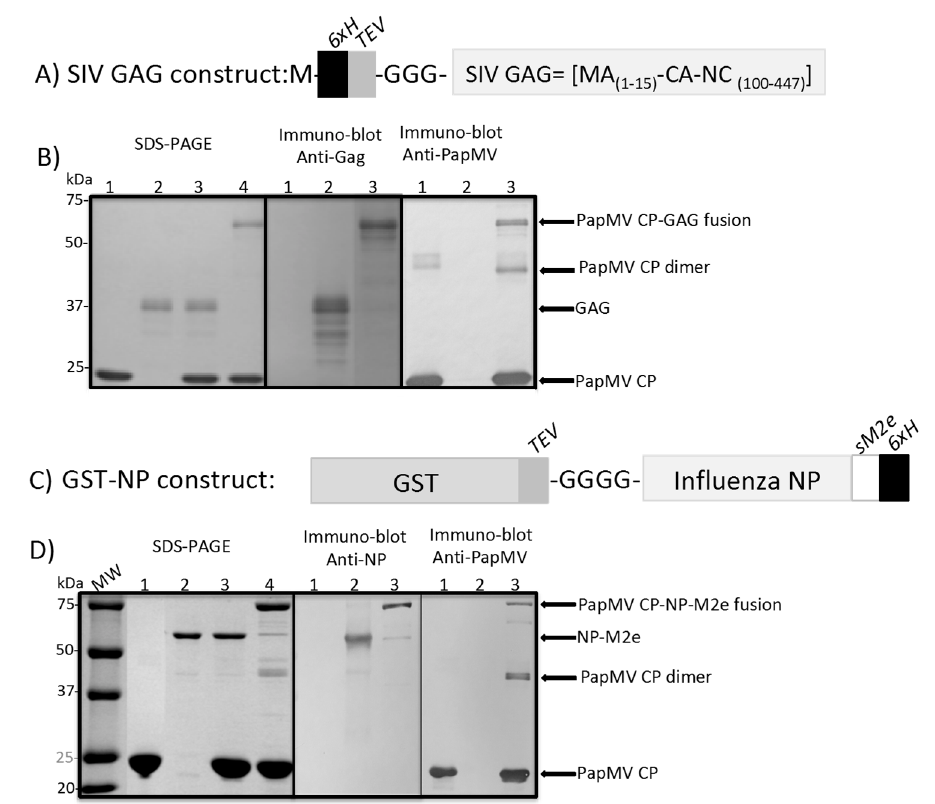
Figure 1. Coupling of the recombinant proteins to the PapMV nanoparticle (nano) vaccine platform using sortase A (SrtA). ( A ) Schematic representation of the simian immunodeficiency virus (SIV) group-specific antigen (GAG) protein clone. In brief, a 6xH tag was fused directly after the first methionine (M) start codon followed by the tobacco etch virus (TEV) protease cleavage site, the GGG SrtA donor motif, the N-terminus of the SIV matrix (MA 1–15) and the fragment 100–447 of the SIV- capsid and nucleocapsid (CA-NC). Upon cleavage with the TEV, an extra G is added to the N- terminus of GAG, which generates the four glycine (GGGG) N-terminus of the protein. ( B ) SDS-PAGE (left panel), 1: PapMV nano (2 µg), 2: SIV GAG (0.3 µg), 3: PapMV nano (2 µg) + SIV GAG (0.3 µg) and 4: Nano-GAG (2 µg). Molecular weights markers are shown to the left of the gel. Immuno-Blot performed with anti-SIV mac p27 (middle panel), 1: PapMV nano (2 µg), 2: SIV GAG (0.3 µg), 3: Nano- Nano-GAG (2 µ g). Immuno-Blot performed with anti-PapMV-CP (right panel). 1: PapMV nano (1 µ GAG (2 µg). Immuno-Blot performed with anti-PapMV-CP (right panel). 1: PapMV nano (1 µg), 2: SIV GAG (0.15 µg), 3: Nano-GAG (1 µg). ( C ) Schematic representation of the influenza nucleoprotein